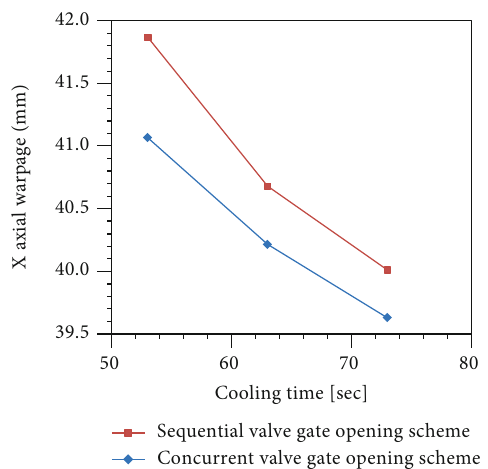
Figure 12: Warpage total deformation respect to the cooling